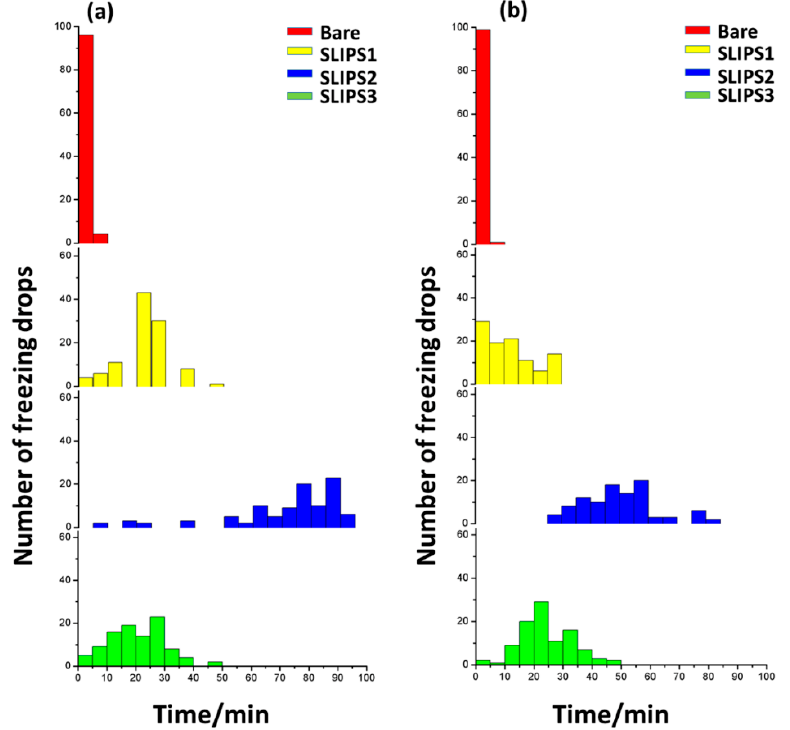
Figure 6. The number of freezing drops on bare samples, SLIPS1, SLIPS2 and SLIPS3 in each time ◦ C ( a ) and − 10 ◦ C ( b period at − 5 °C ( a ) and − 10 °C ( b ). period at − 5